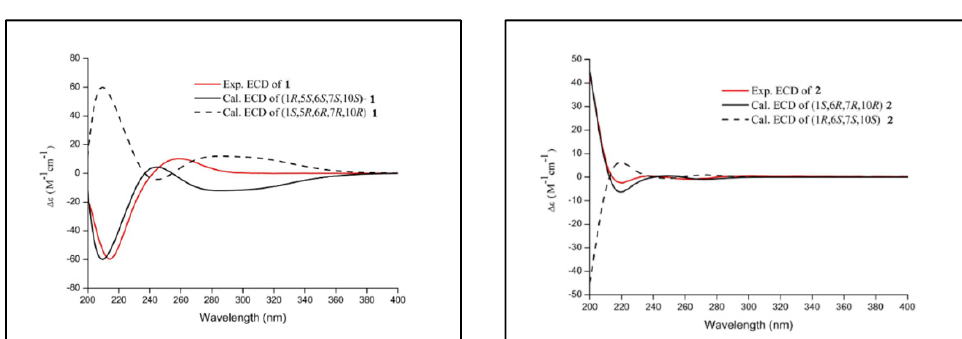
Figure 3. Results of DP4+ analysis for 1 and 2 .